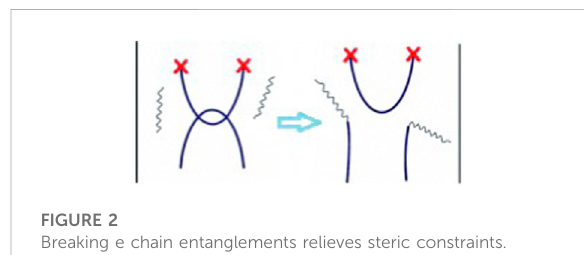
FIGURE 2 Breaking e chain entanglements relieves steric